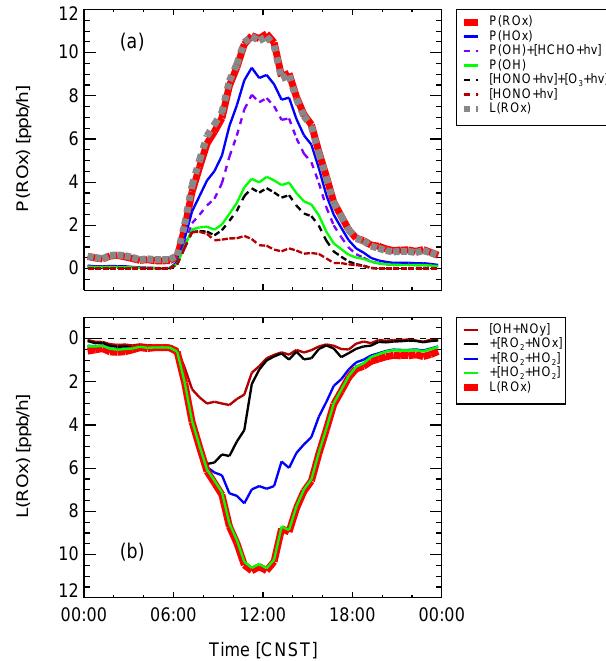
Fig. 6. Production (a) and loss rates (b) of RO x radicals ( =OH+HO 2 +RO 2 ) calculated with RACM-MIM-GK (M0). Panel (a) : breakdown of the primary RO X production resulting from photolytic processes and ozonolysis. P (OH) , P (HO x ) , and P (RO X ) denote total, primary production rates of OH , HO x , and RO X , respectively. Panel (b) : breakdown of the RO X loss caused by radical termination reactions. The brown solid line denotes the loss rate by OH+NO y , the black solid line by OH+NO y and RO 2 +NO x , etc. The total RO X loss rate is given by L (RO X ) which is equal in magnitude to P (RO X ) shown in panel (a) . Legends: the expressions embedded in square brackets represent the corresponding chemical conversion rates.